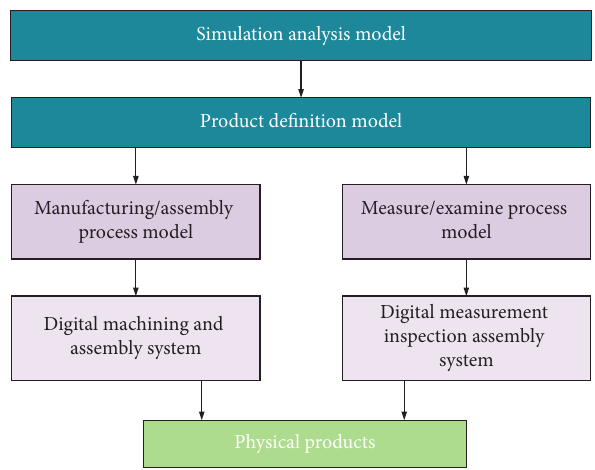
Figure 3: Operation process of digital